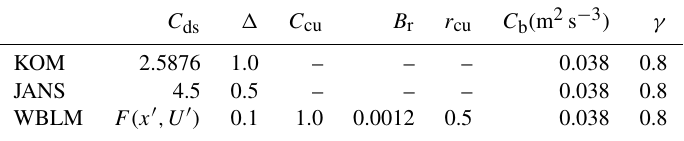
Table 2. Constants used for all the experiments in Sect. 3. C ds and (cid:49) are white-capping dissipation parameters in Eq. (12); F(x (cid:48) ,U (cid:48) ) is the new dissipation parameter for WBLM in Eq. (18); C cu , B r , and r cu are cumulative dissipation parameter for WBLM in Eq. (19); C b and γ are JONSWAP (Hasselmann et al., 1973) bottom friction and Battjes and Janssen (1978) depth-induced wave-breaking parameters.